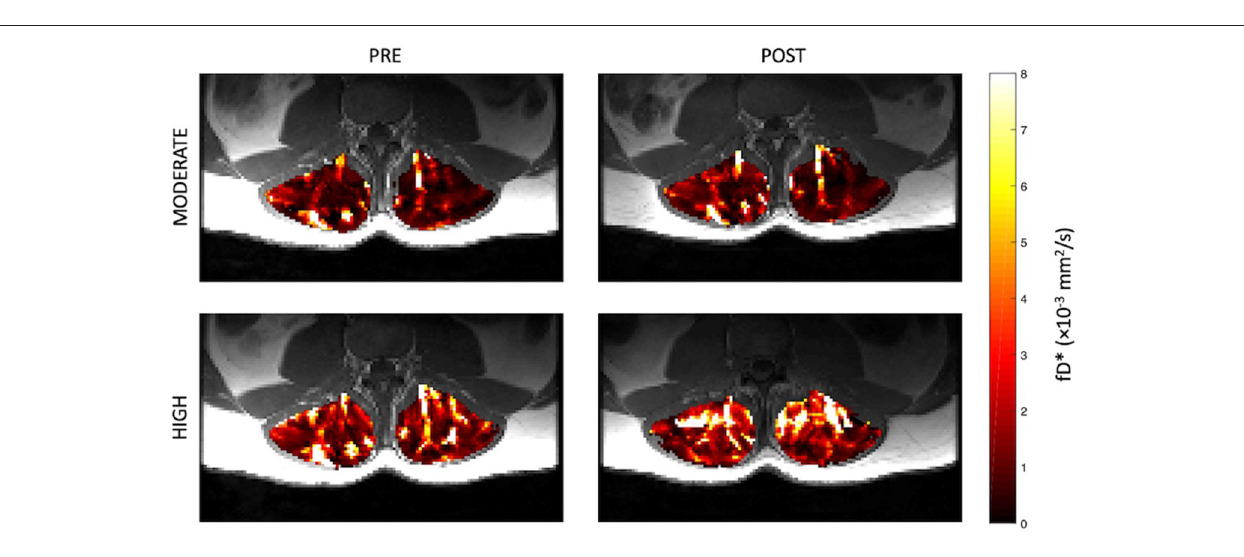
FIGURE 7 | Representative parameter maps of fD* before and after both moderate (top) and high (bottom) intensity resisted lumbar extension